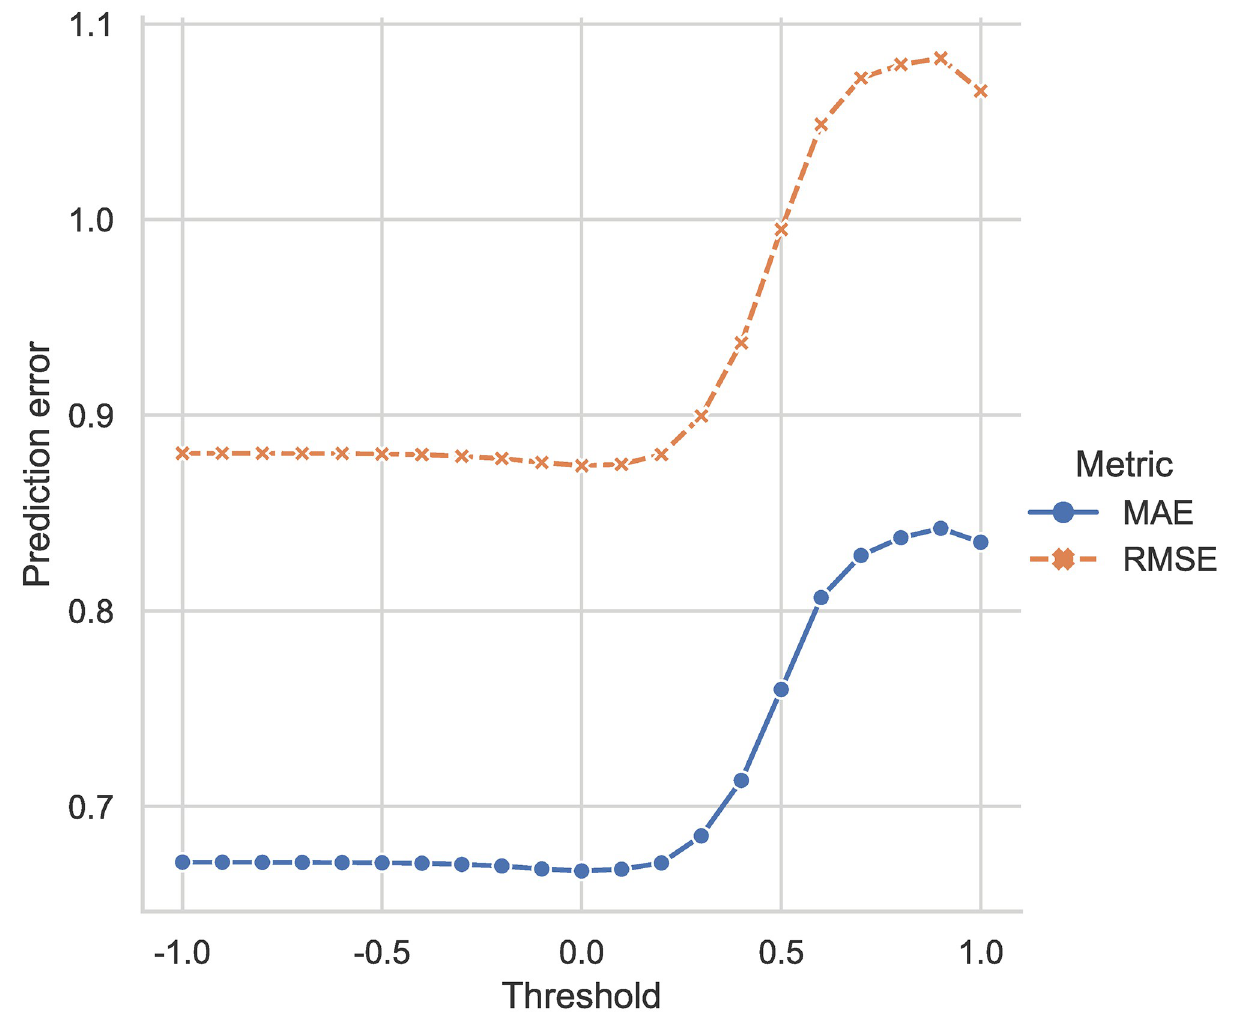
Fig 2. Comparison of errors generated by different similarity selection thresholds under the same experimental conditions (mean absolute error and root mean square error on MovieLens with selected users).